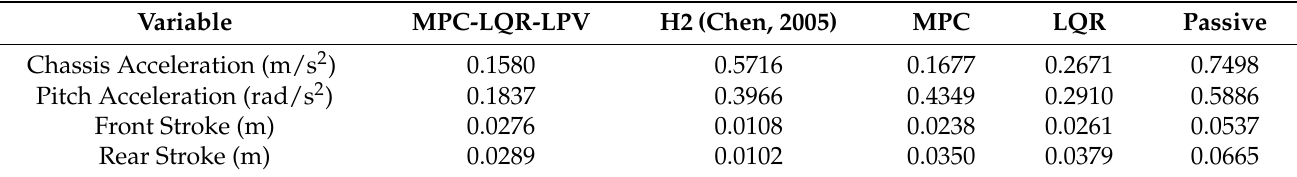
Table 2. RMS Values performance.